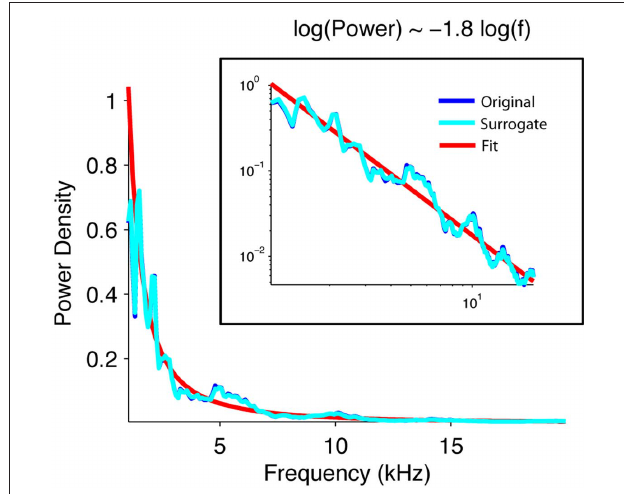
FIgure 2 | The power density of the acoustic waveform of water scales inversely with frequency. Normalized power density of the waveform of the original brook recording (blue), its phase-surrogate transform (cyan), and a linear fit (red). The surrogate was computed as an inverse Fourier transform of the Fourier transform of the signal whose phases were randomized. Note that the power spectrum scales with the inverse of the